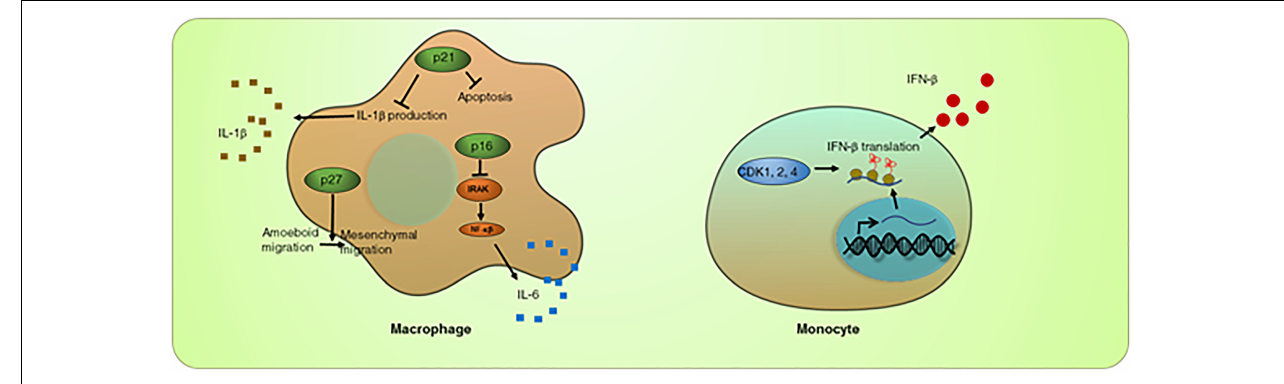
FIGURE 1 | Roles of cell cycle regulators in innate immune response. CDKs play a positive role in IFN- β translation. CDK inhibition leads to reduced IFN- β mRNA in the polysome complex. On the other hand, CDK inhibitor p21 CIP1 is required to suppress overproduction of IL-1 β , and p16 INK4A is required to suppress IL-6,